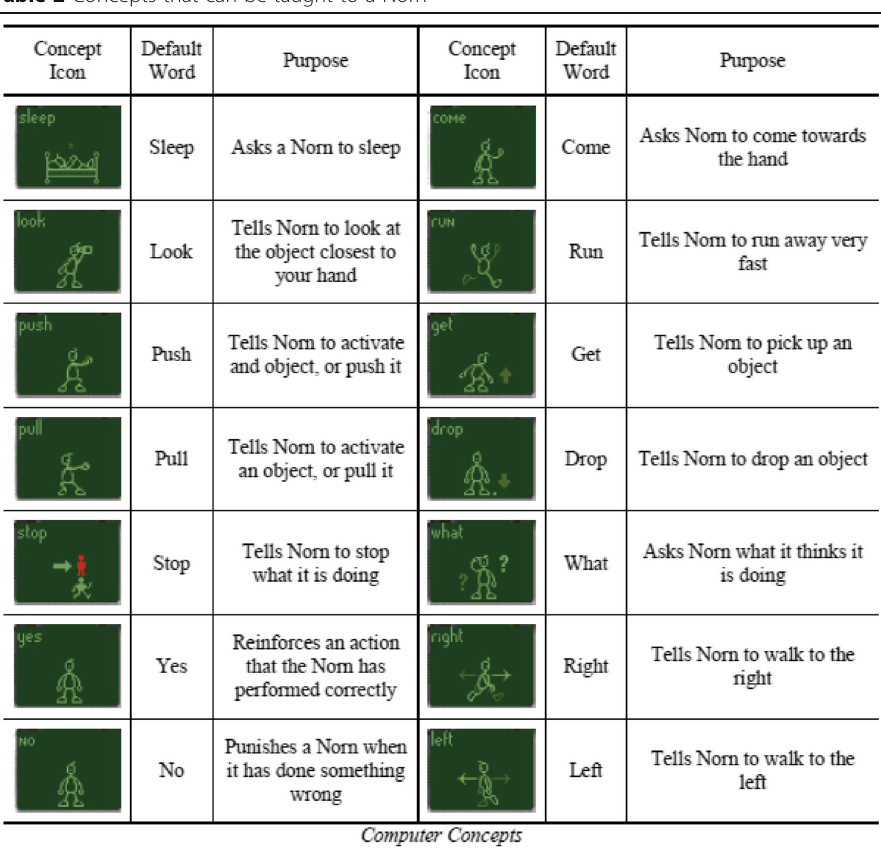
Table 2 Concepts that can be taught to a